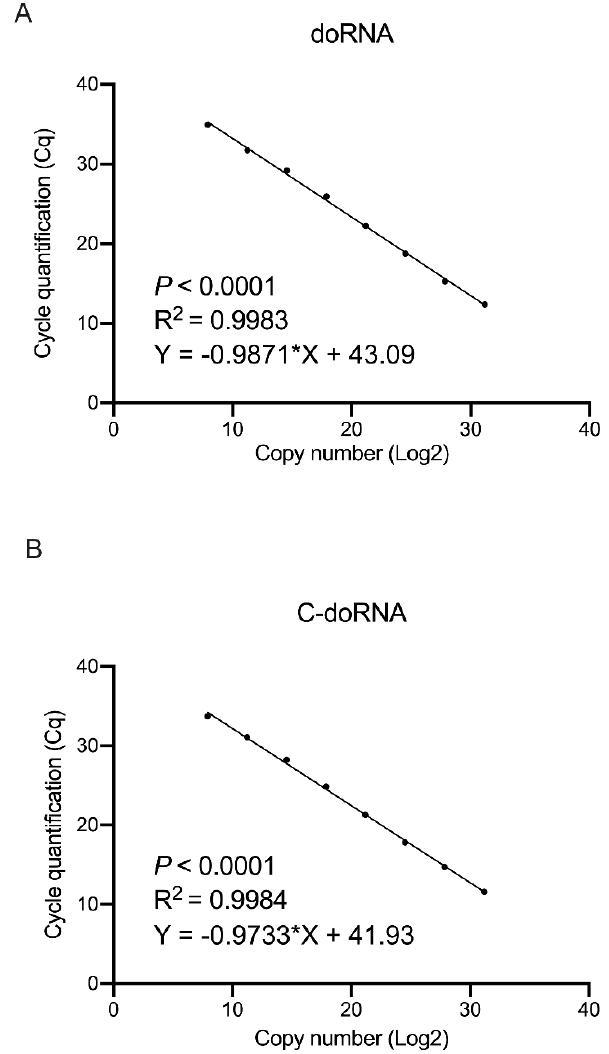
Figure 6. doRNA and C-doRNA detection by splinted 5’ adapter RT-qPCR is linear over a range of 7 logs. ( A , B ) Standard curves were established using synthetic doRNA ( A ) or C-doRNA ( B ) serial dilution to calculate doRNA or C-doRNA copy numbers in various cell and tissue samples.